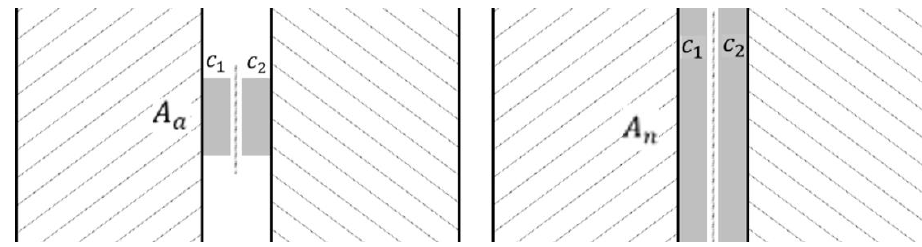
Figure 3. The ratio of actual contact area to the nominal contact area.